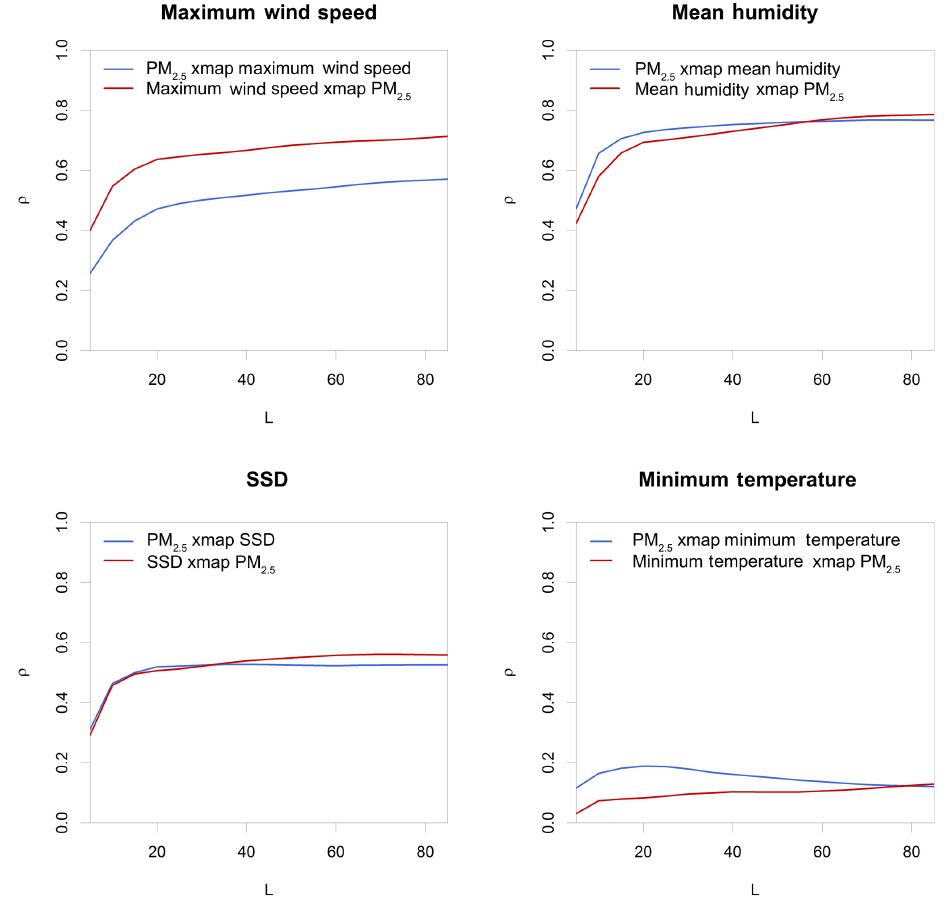
Figure 1. Illustrative CCM results to demonstrate the bidirectional coupling between meteorological factors and PM 2 . 5 concentrations in Beijing (2014, winter). ρ : predictive skills. L : the length of time series. A xmap B stands for convergent cross mapping B from A, in other words, the causality of variable B on A. For instance, PM 2 . 5 xmap mean humidity stands for the causality of mean humidity on PM 2 . 5 concentrations. Mean humidity xmap PM 2 . 5 stands for the feedback effect of PM 2 . 5 concentrations on mean humidity. ρ indicates the predictive skills of using mean humidity to retrieve PM 2 . 5